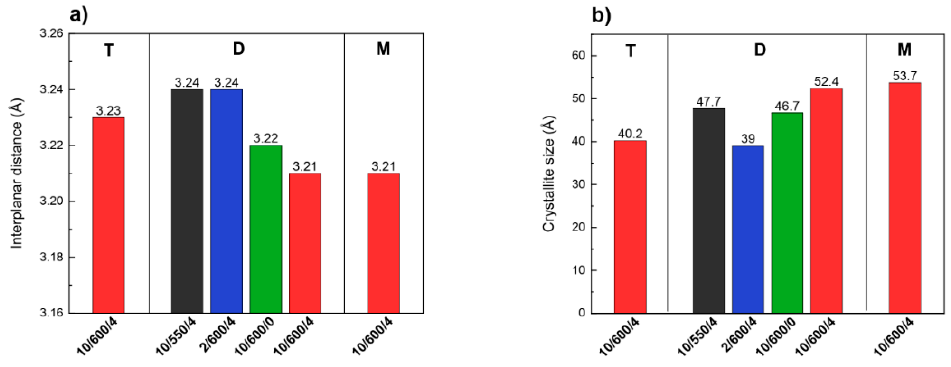
Figure 5. Interplanar distances ( a ) and crystallite sizes ( b ) of different g-C 3 N 4 samples.